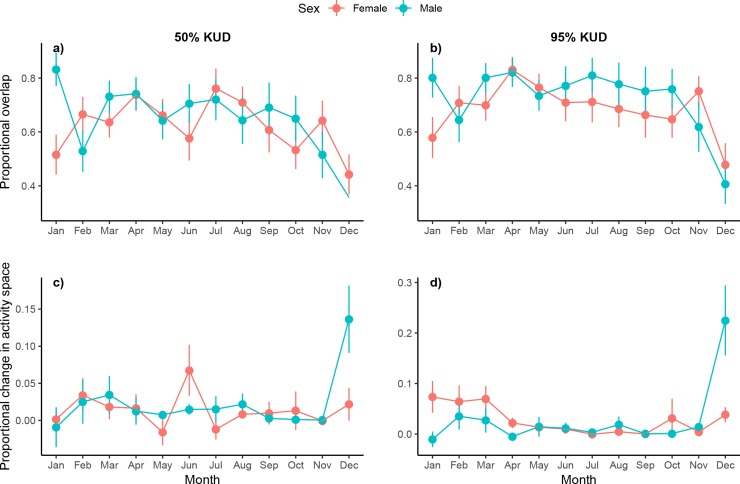
Monthly space use estimates for acoustically tagged blacktip reef sharks at Orpheus Island.(a-b) Proportional overlap of monthly 50 and 95% KUDs of 40 blacktip reef sharks at Orpheus Island (females: red; males: blue); high values of overlap indicate little change in the location of KUDs between consecutive months. (c-d) Proportional change in monthly cumulative 50 and 95% KUDs; high positive values indicate sharks are expanding their space use to include previously unused areas. Panels include mean and standard error.